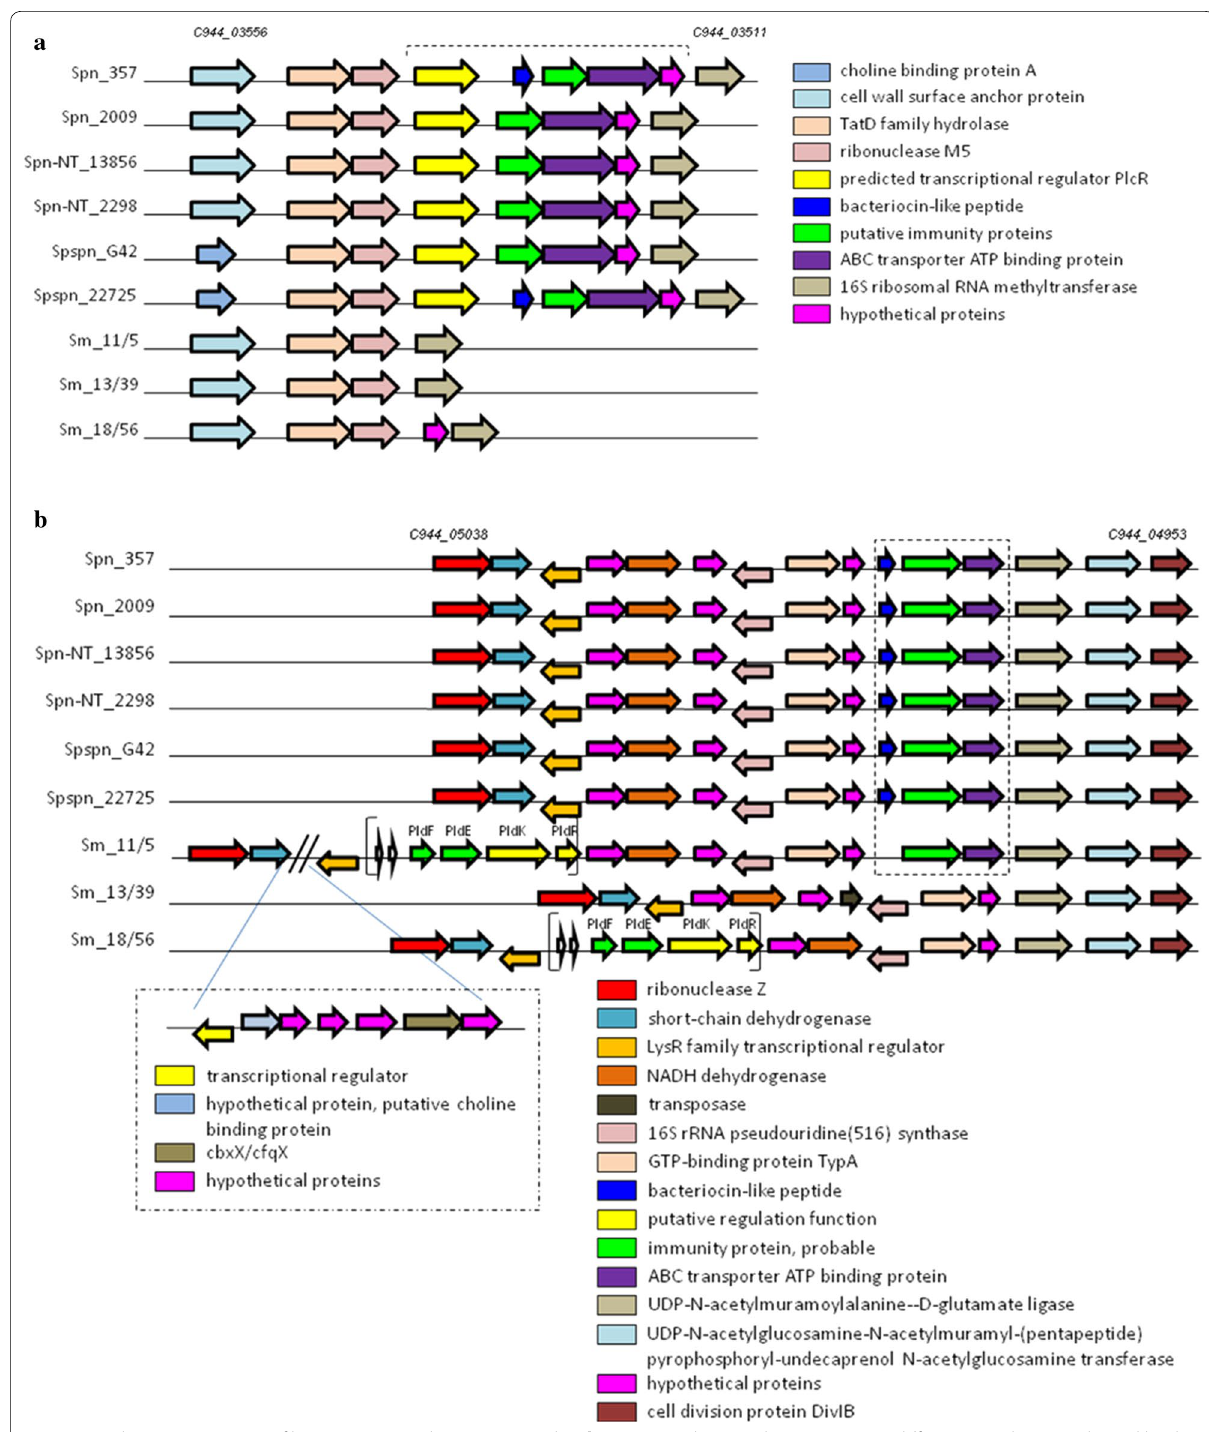
Fig. 3 Graphic representation of lactococcin 972 clusters III ( a ) and IV ( b ), respectively. Homologous genes in different samples are indicated by the same color. Square brackets point a part of the pld locus in S. mitis genomes in the bottom picture. Unfilled arrows mark the fragments of nucleo- tide sequences which are homologous to pld1 - 3 or pld4 genes (see